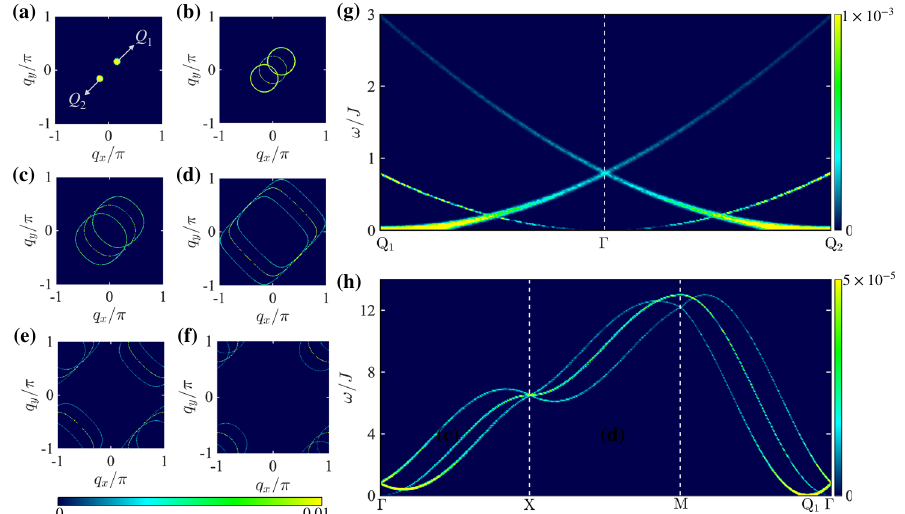
Fig. 5 Spin waves in the spin spiral (SS) phase. a – f Constant-energy contours of the dynamical spin structure factor S ( q , ω ) calculated in the SS phase, realized at zero magnetic fi eld, at energies a ω = 0, b ω = J , c ω = 3 J , d ω = 6 J , e ω = 8 J , and f ω = 11 J . Q 1 ( = − Q 2 ) is the characteristic momentum of the SS phase, as shown in plot ( a ). g , h Plot of S ( q , ω ) along the momentum paths g Q 1 − Γ − Q 2 and h Γ − X − M − Γ . g Symmetrized expansion of the lower right corner of h . The “ soft ” spin-wave mode, which arises above a fi nite energy around the Γ point (0,0), is due to the ferromagnetic correlation within the stripes in the SS phase. The two other spin-wave modes arise from the spiral order in the spin con fi